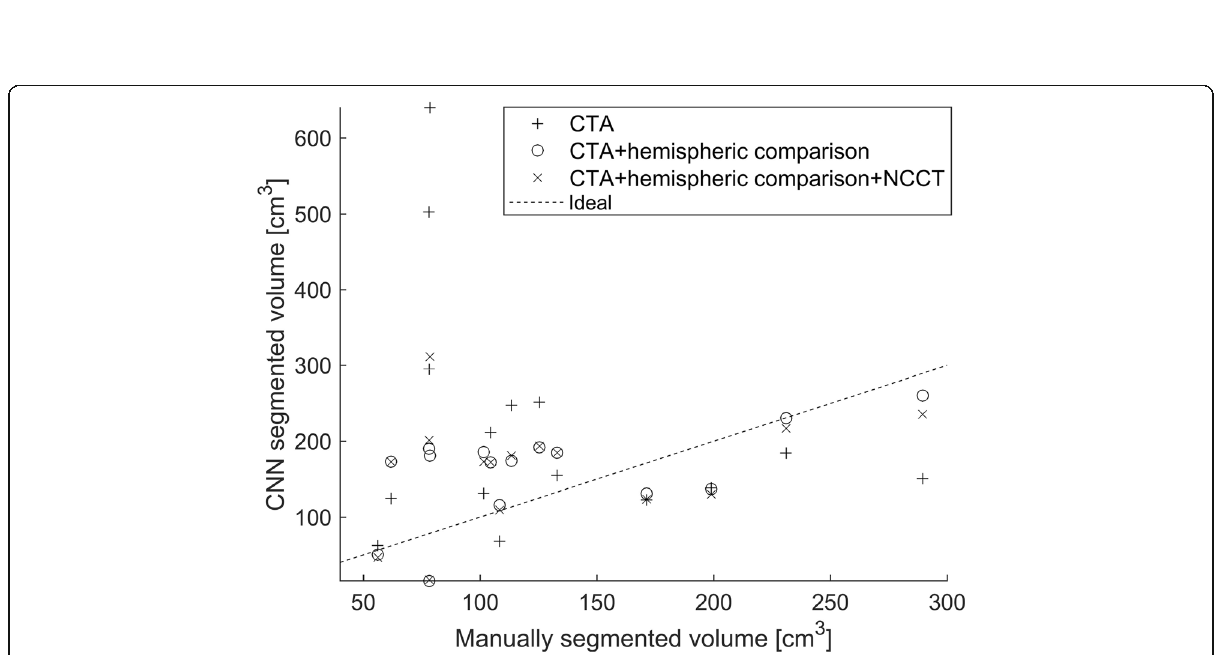
Fig. 5 Stroke lesion volumes of the manual segmentation and three CNN outputs. The largest connected region is used in the volume